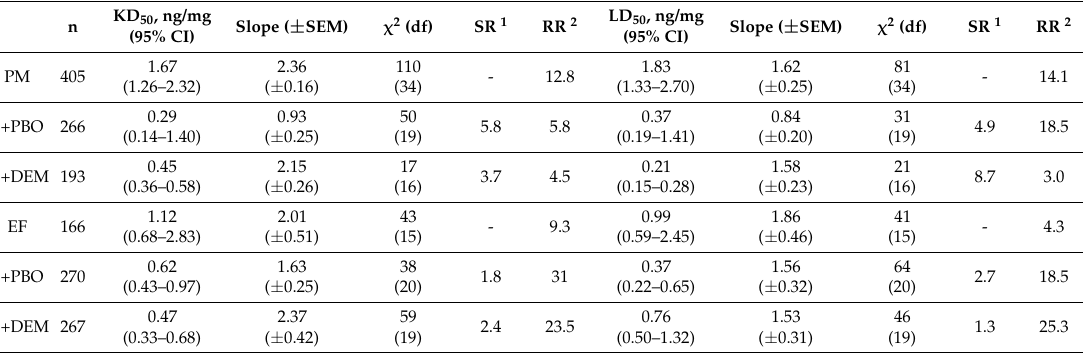
Table 5. Toxicity and synergism of permethrin (PM) and etofenprox (EF) against An. gambiae (Strain A kdr